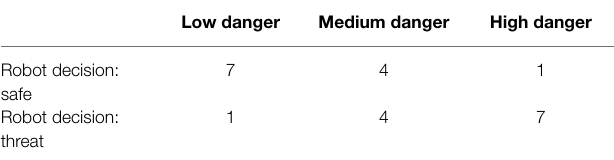
TABLE 1 | Number of scenarios at each level of danger cues and robot decision.